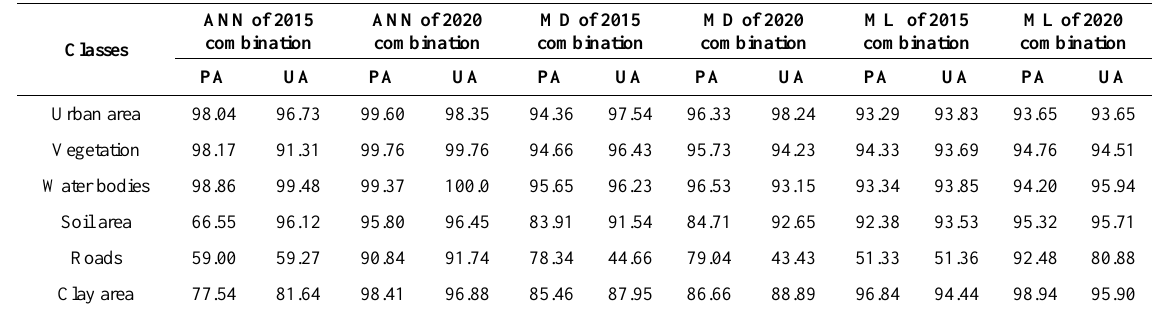
Table 5. Reveals Producer and User accuracies of the MD, ANN, and ML approaches of combined images of 2015 and 2020